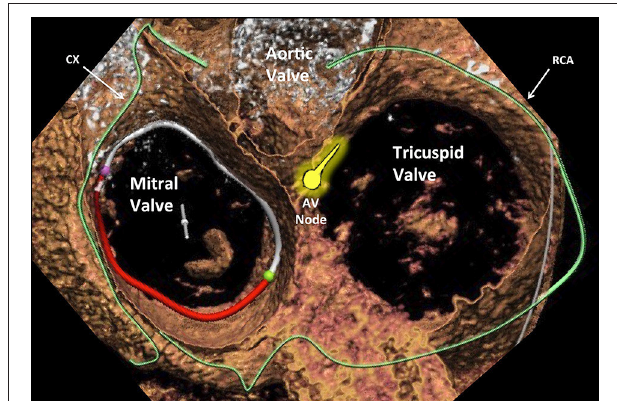
FIGURE 4 | Cross-sectional view of the three heart valves seen from above with atria removed. Advanced editing of a computed tomography image performed with 3mensio (Pie Medical Imaging, Netherlands) software. The proximity of the atrioventricular valves (different area can be appreciated) to the coronary arteries that are located in the atrioventricular groove (the circumflex for the mitral and the right coronary artery for the tricuspid) represents a similar aspect to be taken into account. Cx, circumflex artery; AVN, atrioventricular node; RCA, right coronary artery.